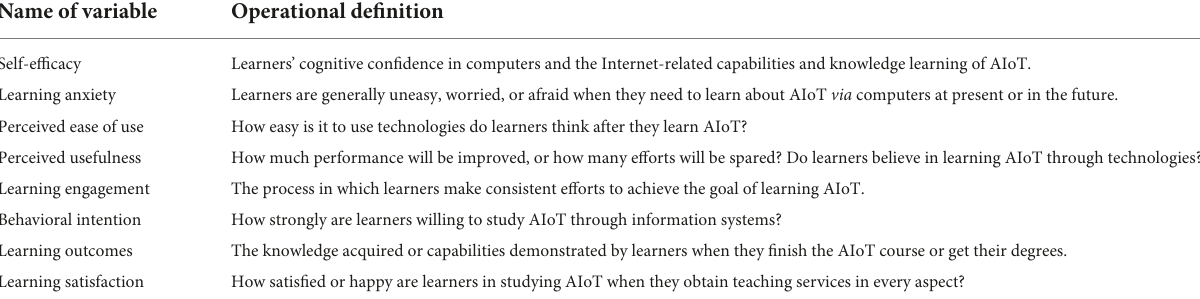
TABLE 1 Operational definitions of all dimensions in the SPOC-AIoT learning